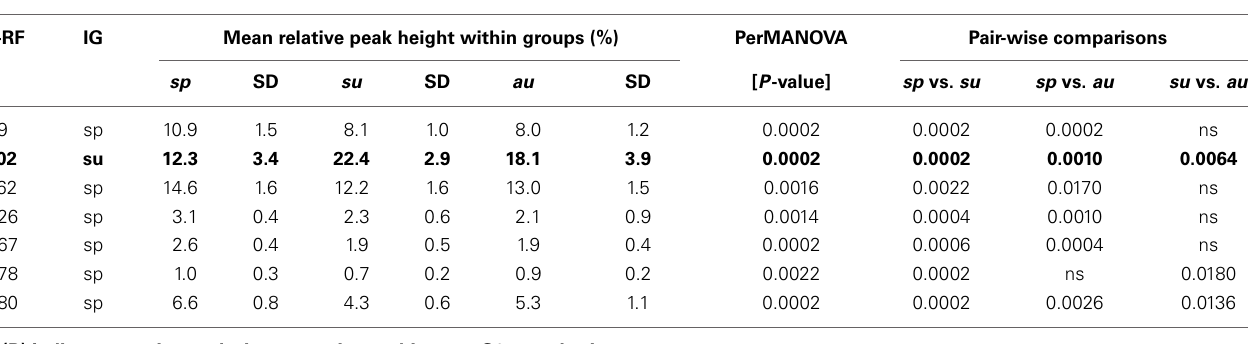
Table 1 | Results of indicator species analysis in combination with univariate ANOVAs based on selected t-RFs of the 16S rRNA amplicon profiles.